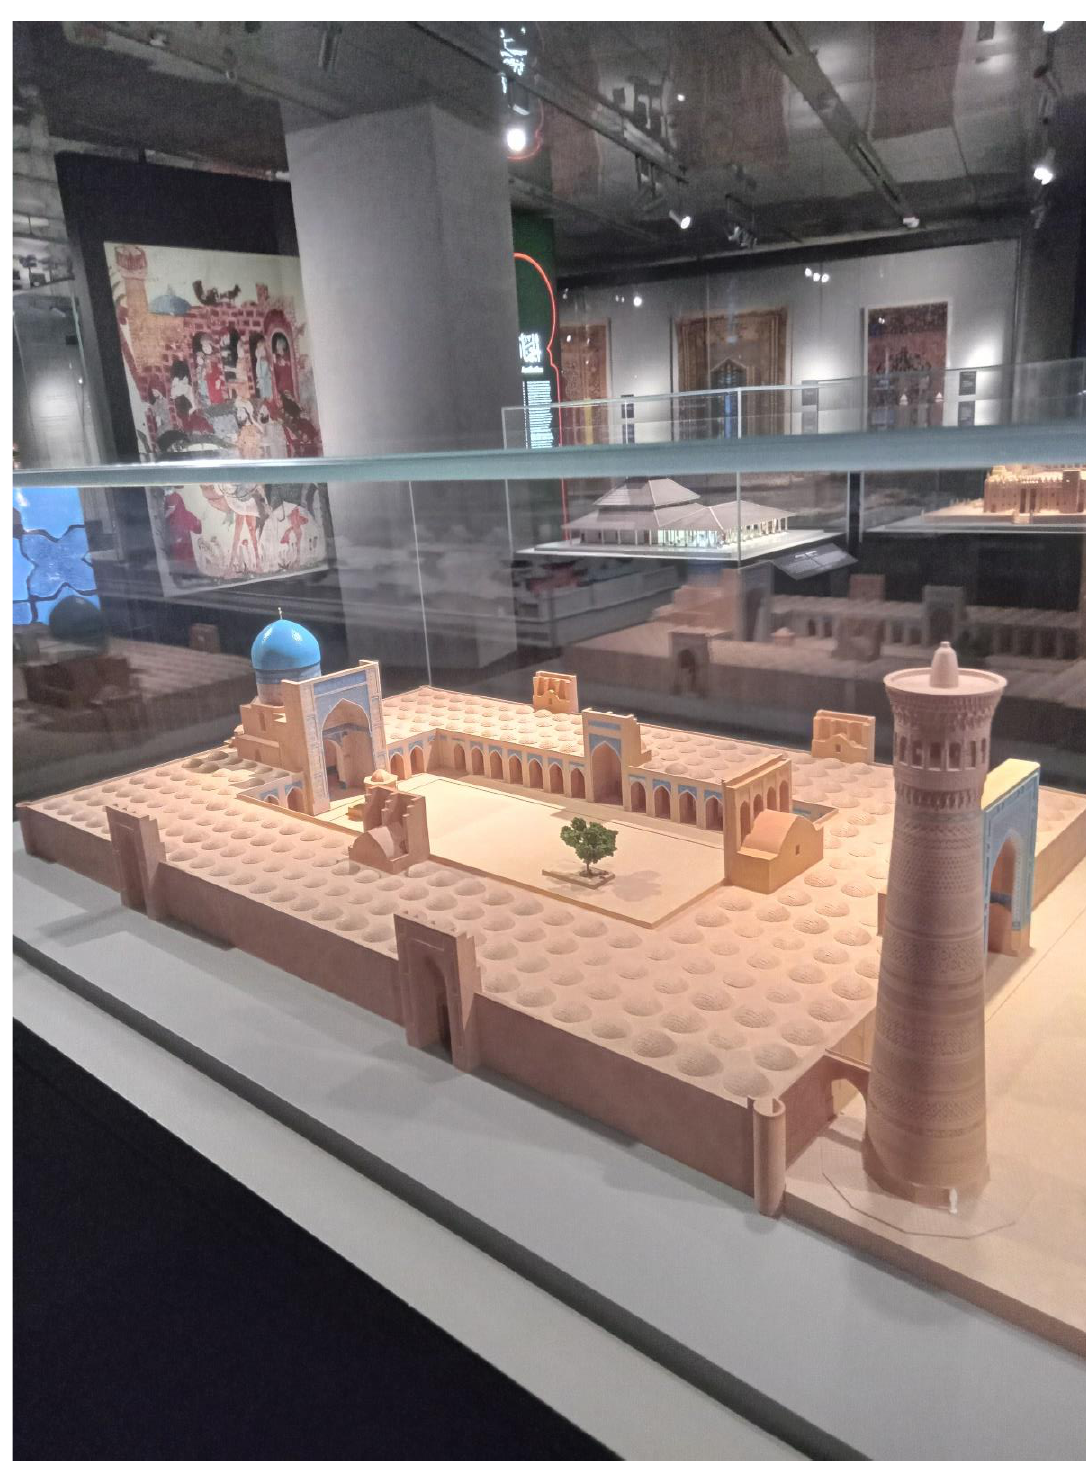
Figure 22. The collection of Islamic art in the King Abdulaziz Center for World Culture (Ithra), Dhahran, Saudi Arabia. Model of the mosque complex of Po-i-Kalyan, Bukhara, Uzbekistan. Photo of the author.